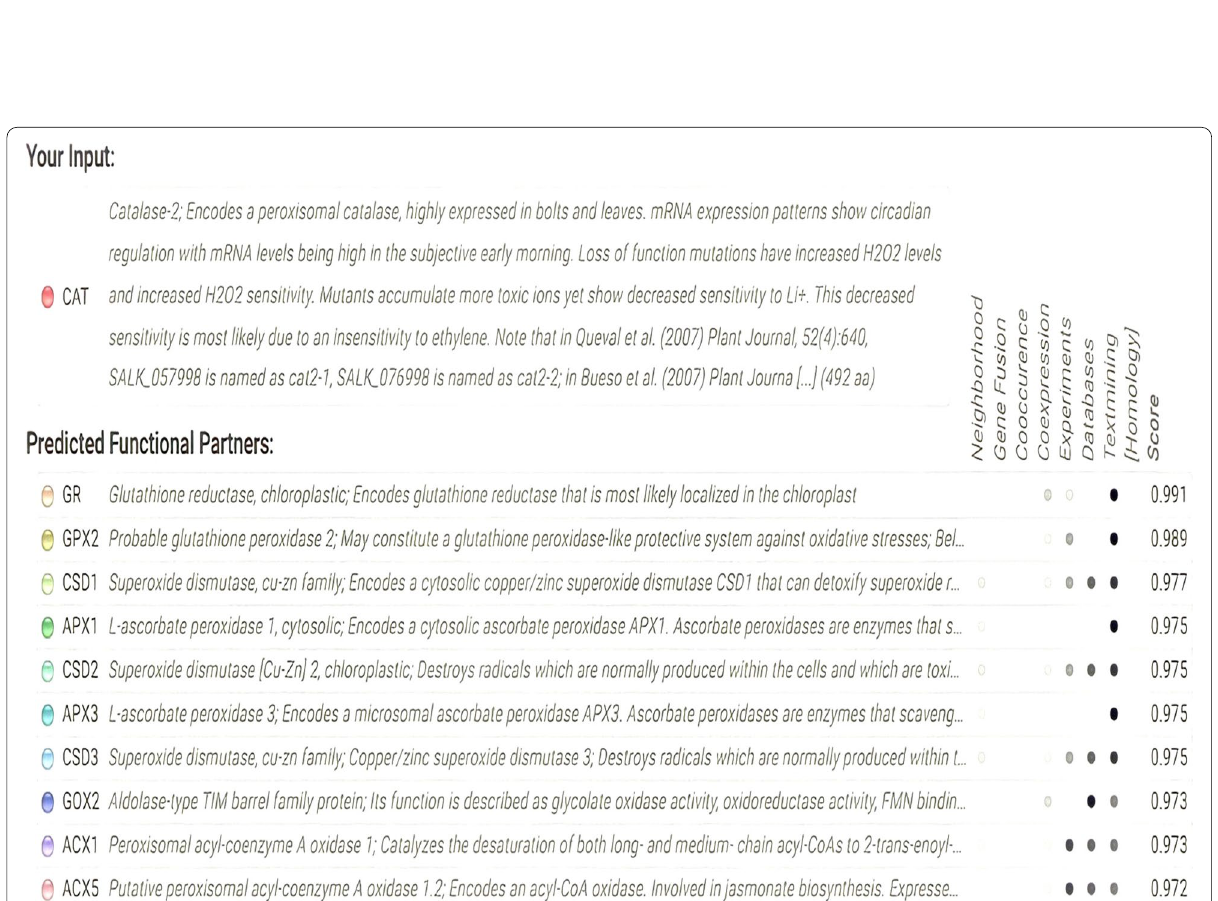
Fig. 8 Predicted interacting protein partners of the query sequence from STRING